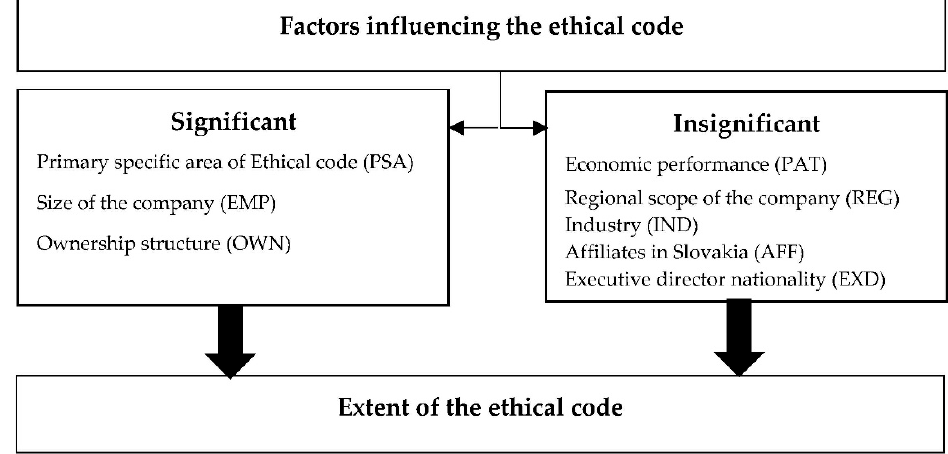
Figure 1. Factors that influence extent of the ethical code (Graphical conclusion). Source: own pro- cessing.